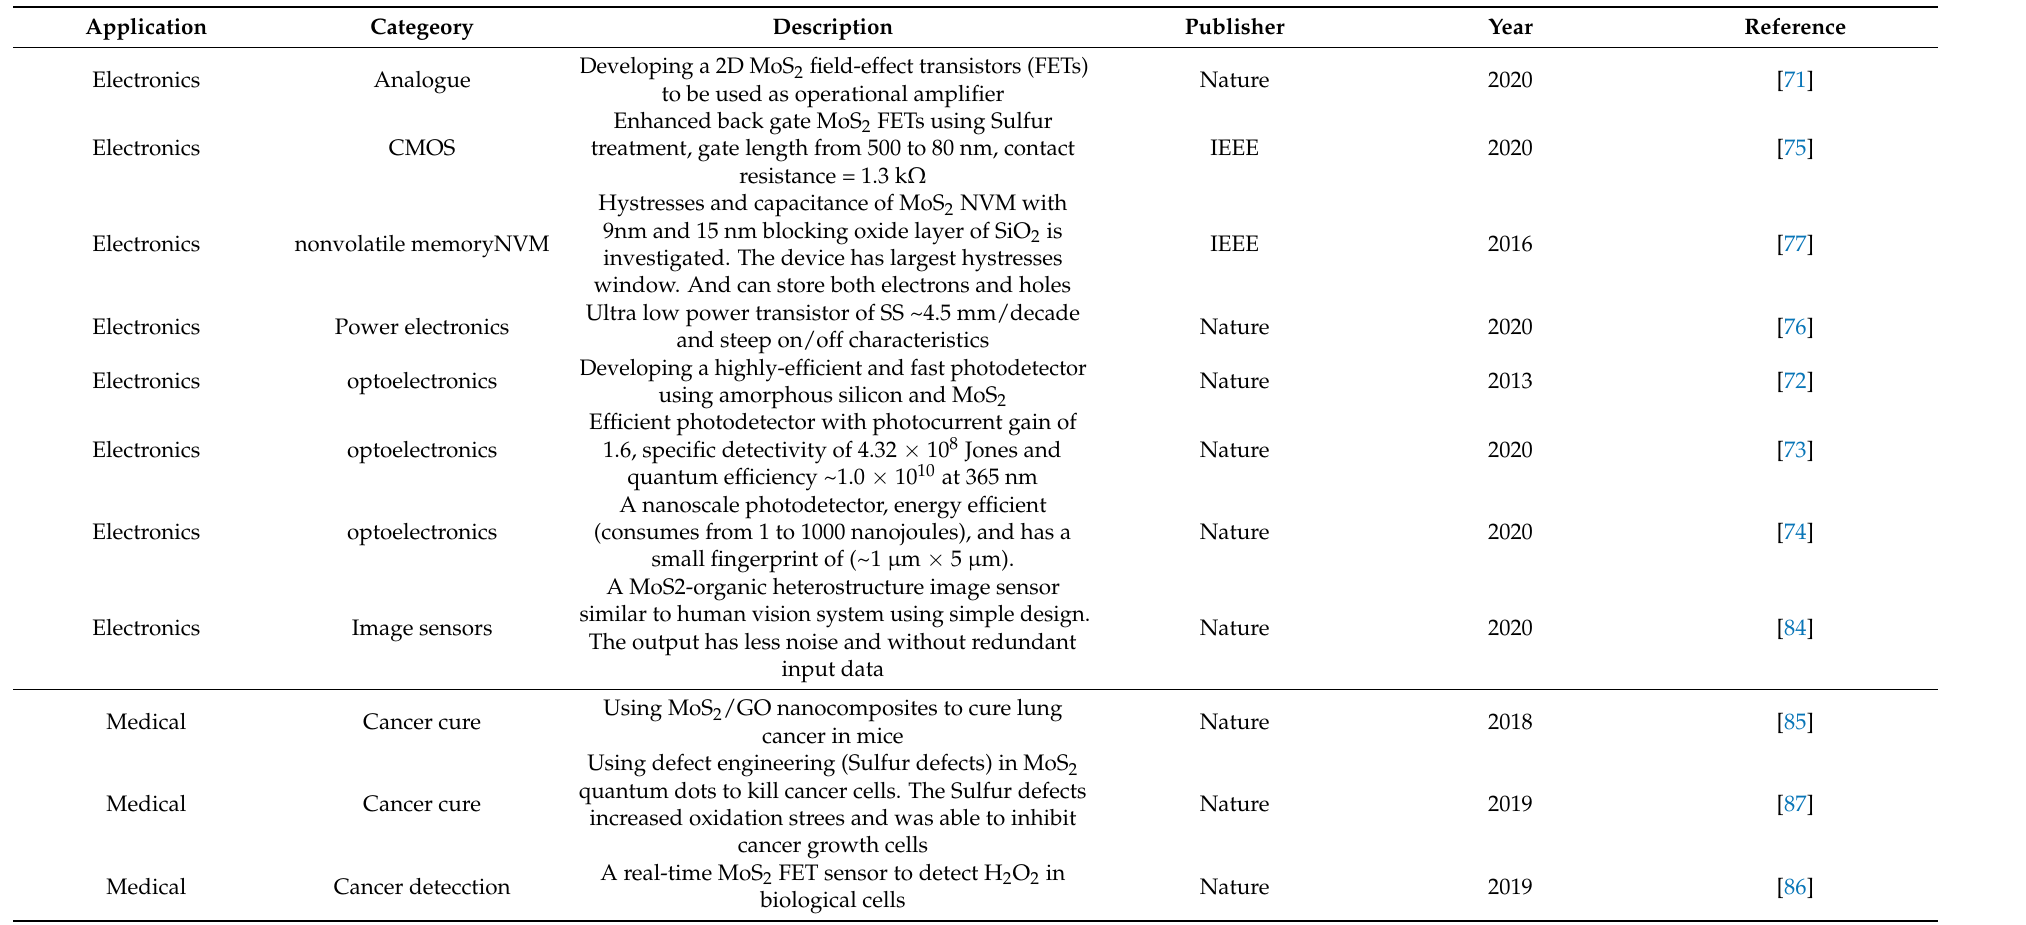
Table 5. Summary of MoS 2